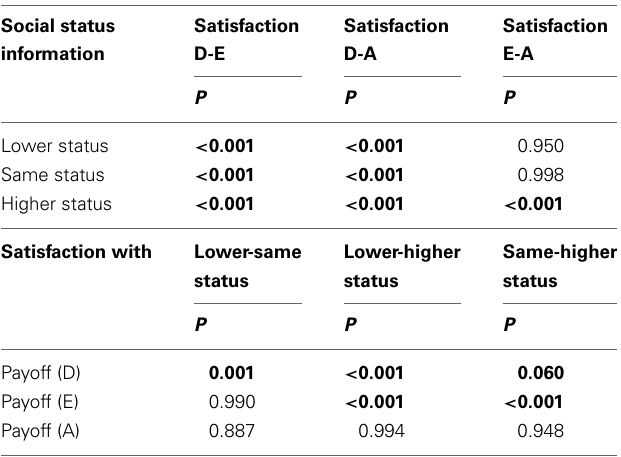
Table 2 | P -values of pairwise comparisons (Sidak-corrected for multiple comparisons) of satisfaction ratings between different payoff allocations and different status